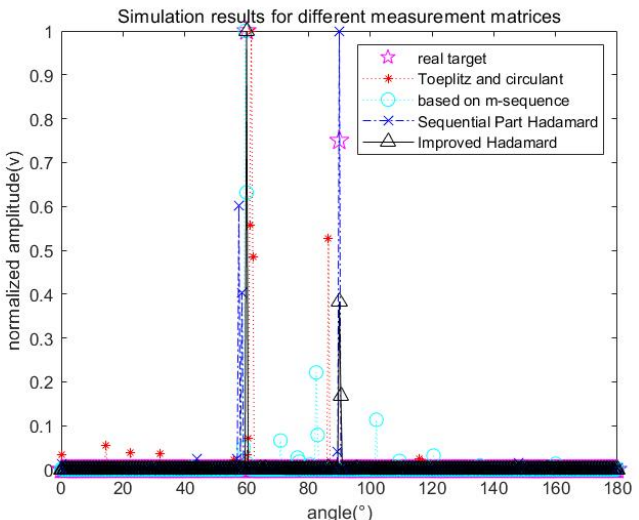
Figure 4. Simulation target reconstruction effect with a compression ratio of 44%.